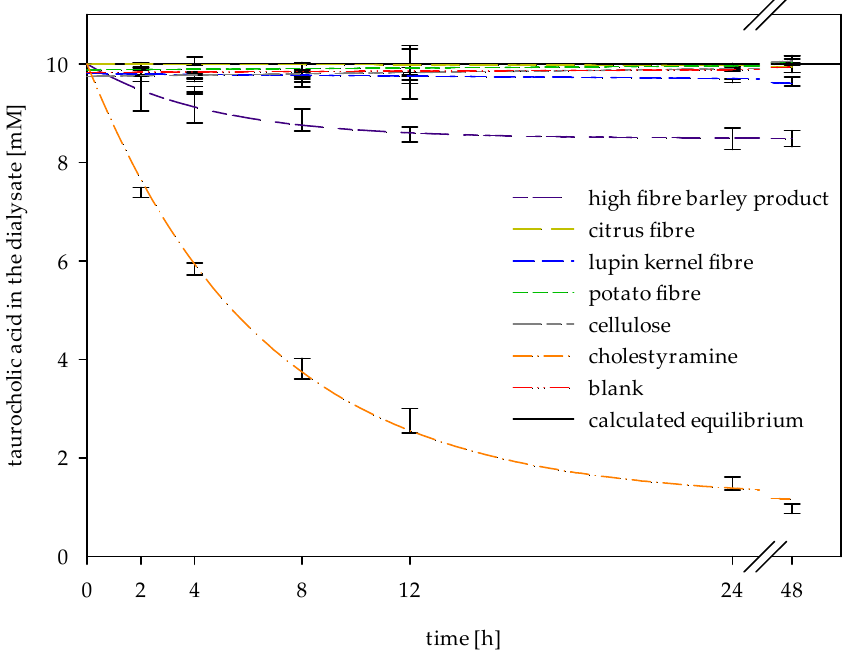
Figure 3. Adsorption of taurocholic acid measured by inverse dialysis model: bile acid concentration as a function of time without (blank) and with different dietary fibre-rich materials and references ( n = 3).